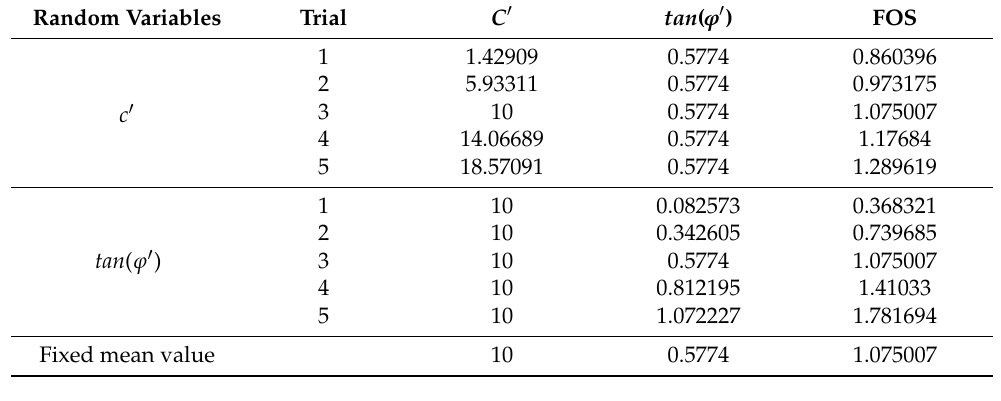
Table 3. Input grid and corresponding safety factor.